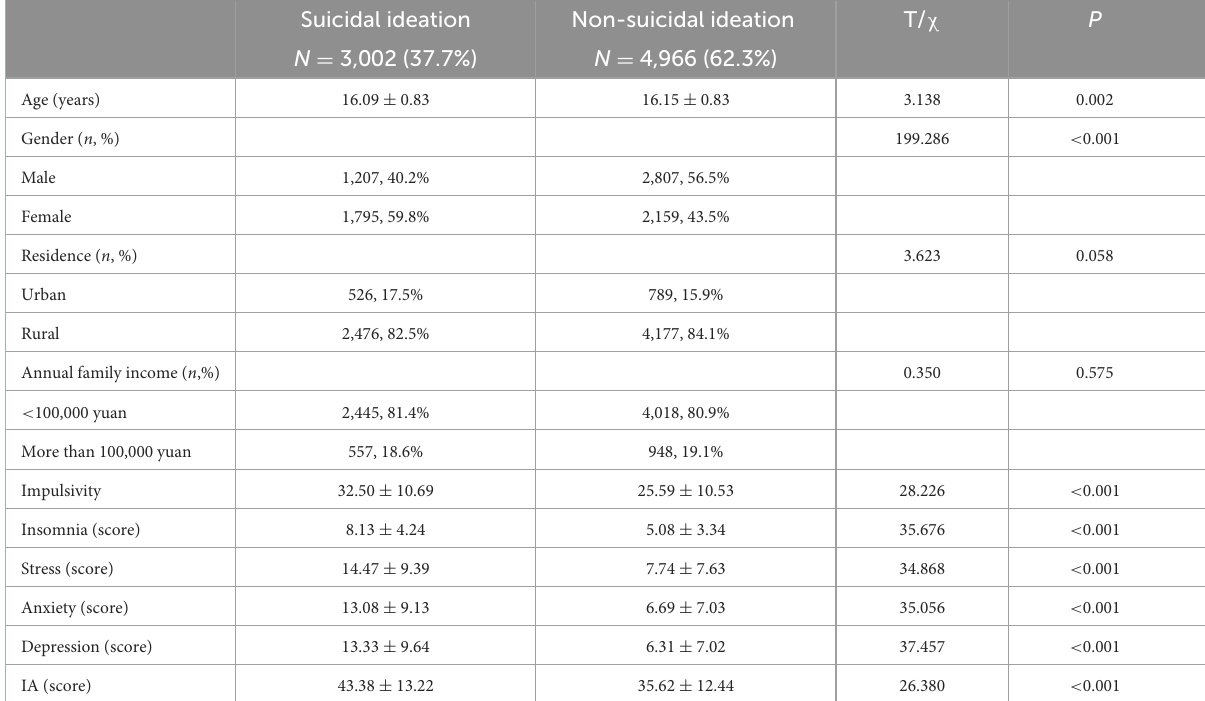
TABLE 1 Demographic data and characteristics of the population with and without suicidal